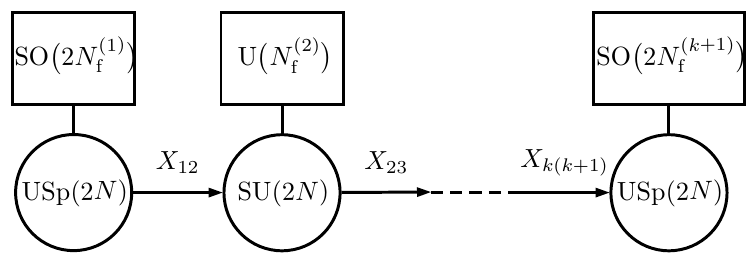
Figure 2 . Five-dimensional infrared quiver gauge theories giving rise to orbifold superconformal (cid:12)eld theories with even n = 2 k and with vector